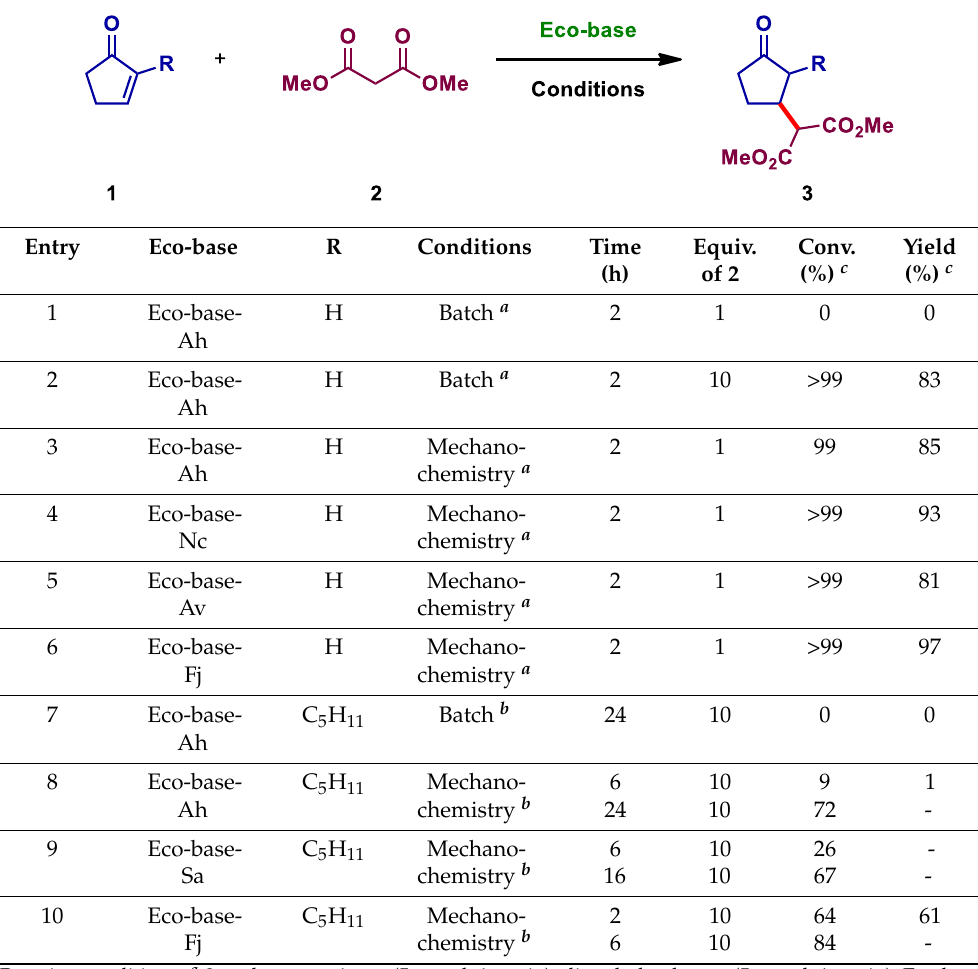
Table 4. Condition optimization for mechanical Michael addition reaction using Eco-bases.